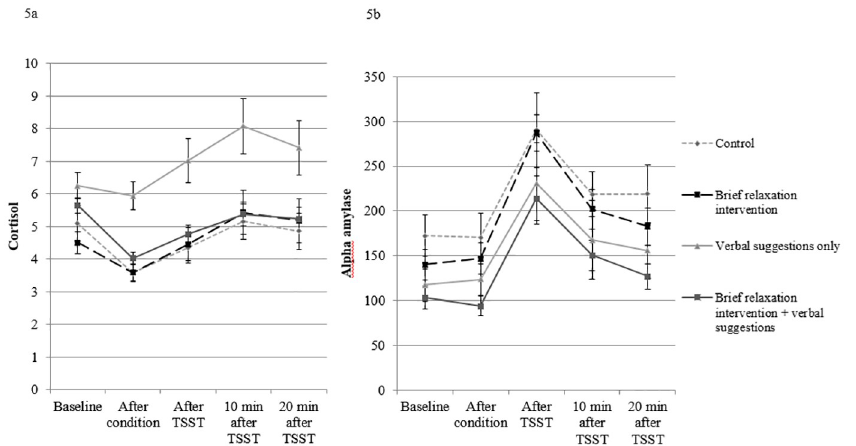
Fig 6. Levels of cortisol in nanomoles per liter (Fig 6a) and alpha-amylase in units per liter (Fig 6b) for the four conditions on the various time points during the lab session. The x-axis represents the various time points, whereas the y-axis represents the level of cortisol and alpha-amylase, respectively. A higher unit on the y-axis represents a higher level of cortisol or alpha-amylase, respectively. Note that the results are presented in a restricted range for a more clear view on the